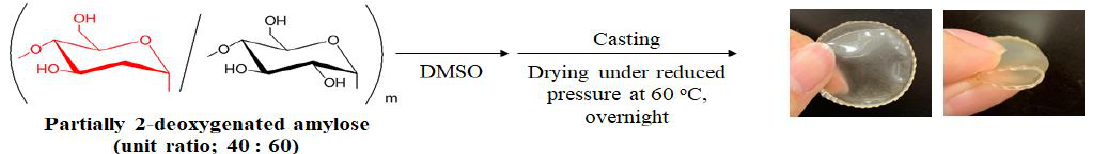
Figure 4. Formation of film from partially 2-deoxygenated amylose (entry 4) by casting DMSO solution and subsequent and subsequent drying.